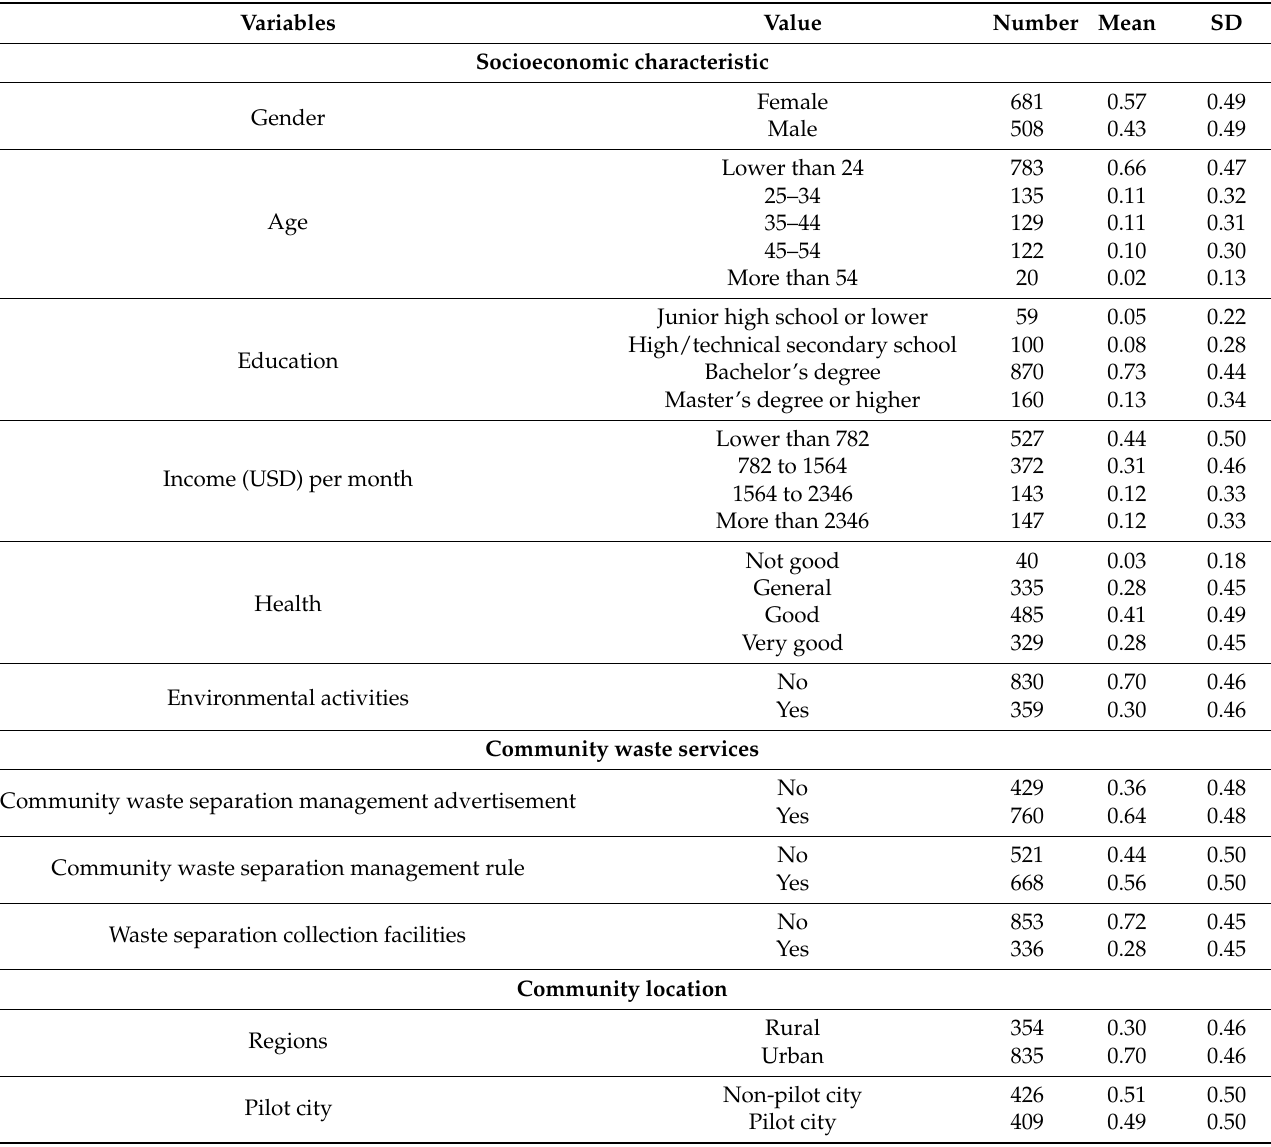
Table 1. Descriptive